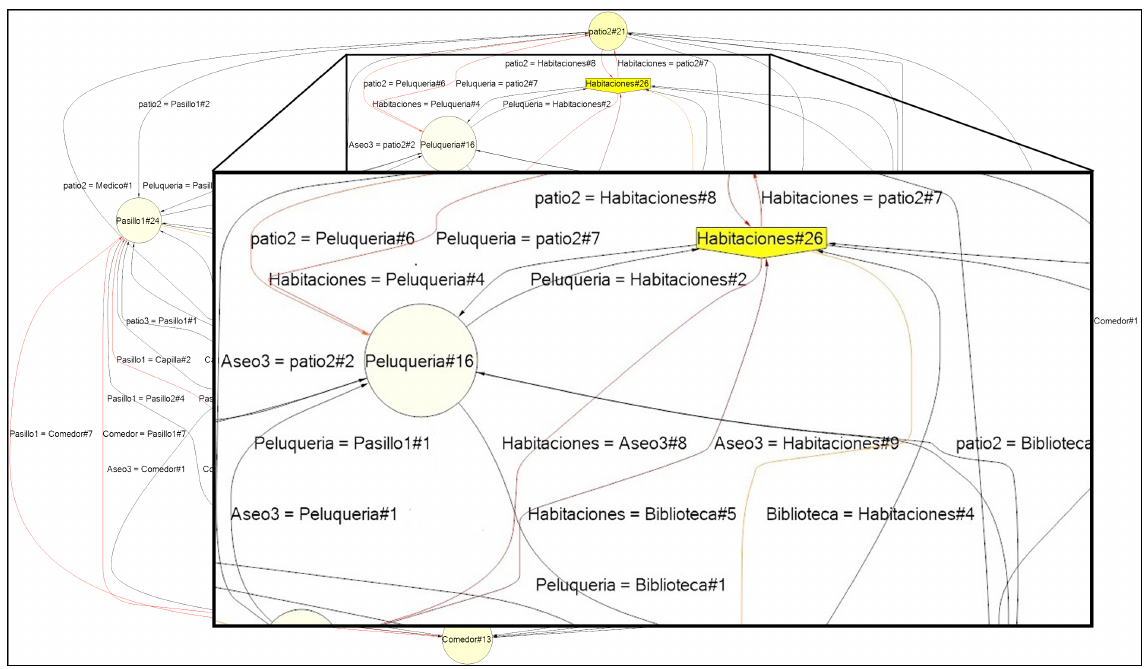
Figure 5. Detail of the heat map of 7th